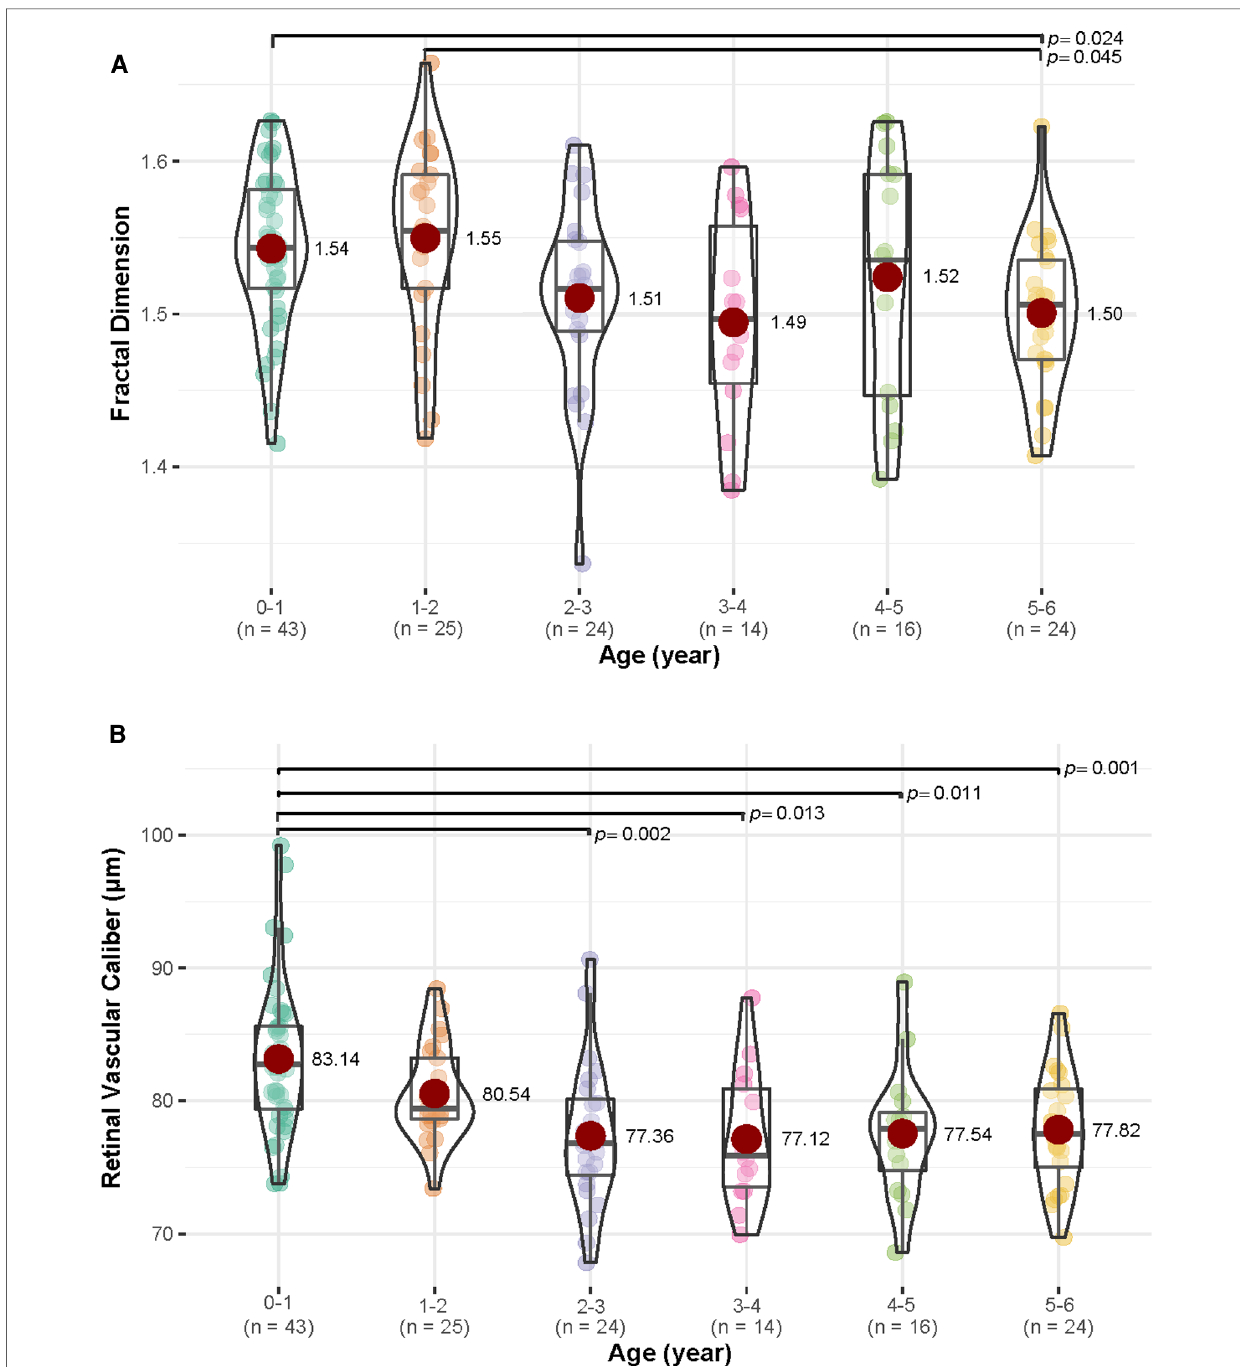
FIGURE 4 The differences in fractal dimension and retinal vascular caliber (µm) among various age groups (year). ( A ) For fractal dimension, children in 0 – 1 and 1 – 2 years age groups had more complex retinal vascular structures than those in age group 5 – 6 years age group ( p <0.05). ( B ) For retinal vascular